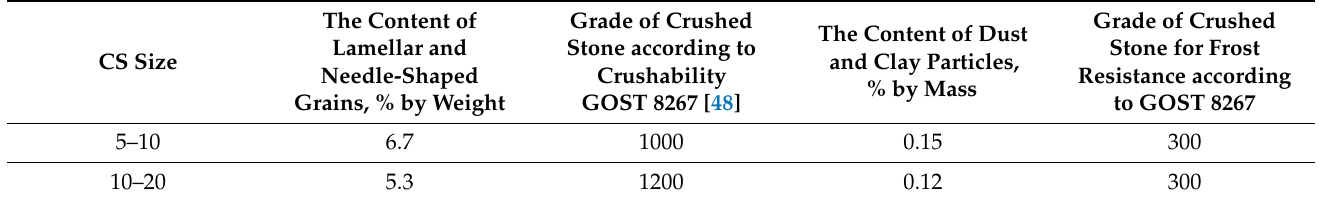
Table 3. Crushed stone (CS) characteristics.